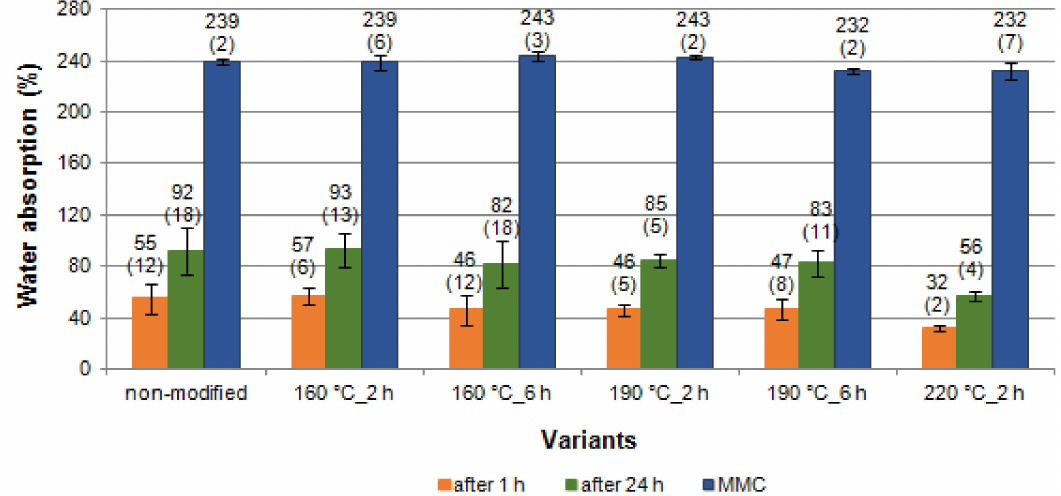
Figure 4. Water absorption (WA) of black poplar thermally modified in nitrogen atmosphere (error bars—standard deviation ( ±